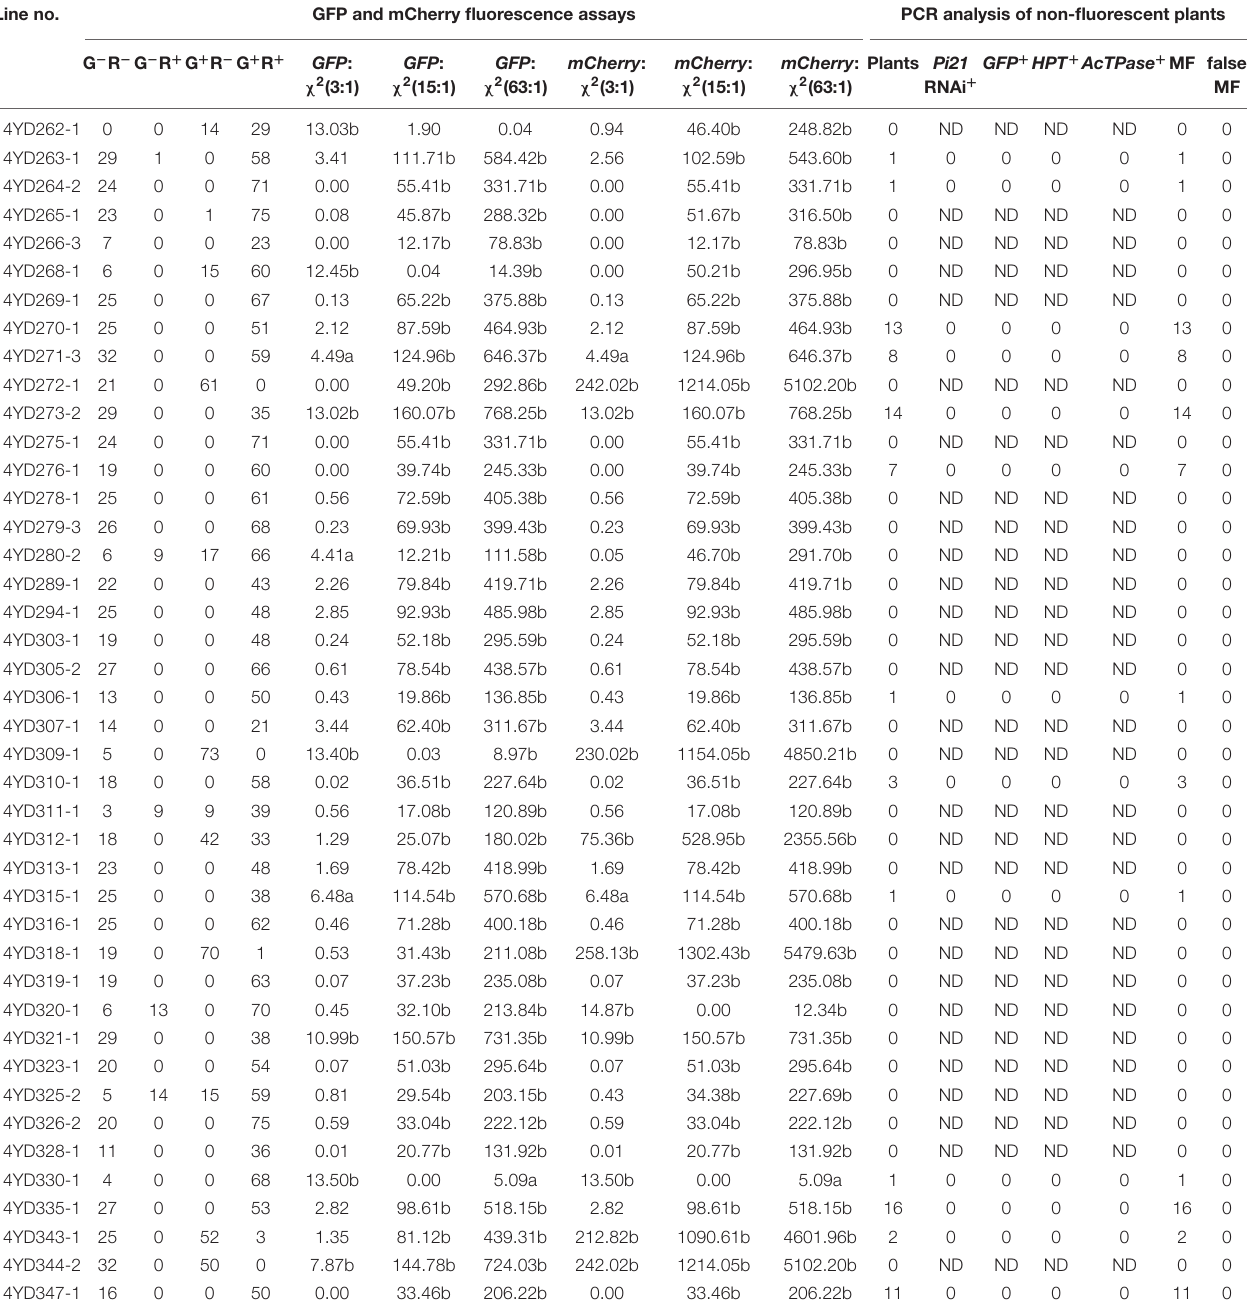
TABLE 2 | Fluorescence assays and PCR analysis of T1 transgenic rice plants transformed with pBDL23. Line no. GFP and mCherry fluorescence assays PCR analysis of non-fluorescent